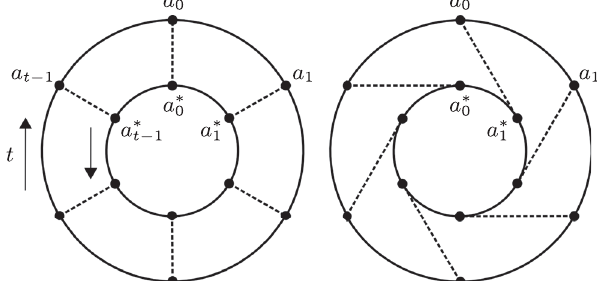
FIG. 2. Two of the diagonal orbit pairings that contribute to the spectral form factor K ð t Þ ¼ j Tr W ð t Þj 2 . The outer circles represent the forward orbit, and the inner the backward, corresponding to terms in the sum-over-histories representations of Tr W ð t Þ and Tr W (cid:3) ð t Þ , respectively. The dashed lines represent the pairing of forward and backward orbits. Diagonal pairings have a r ¼ a (cid:3) r þ s , with addition defined modulo t . On the left and right, we show the s ¼ 0 and s ¼ 1 pairings, respectively.